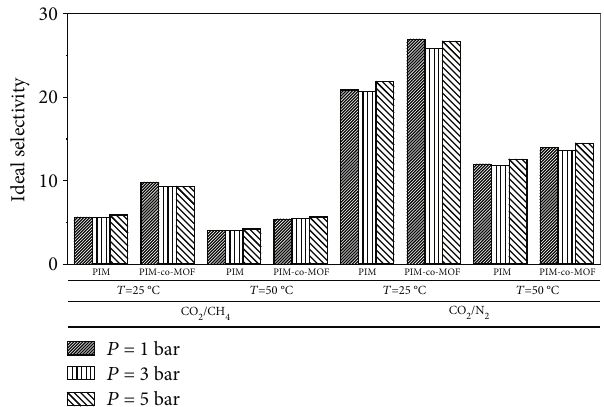
Figure 14: Permselectivity of PIM and PIM-co-MOF at two temperatures and di ff erent